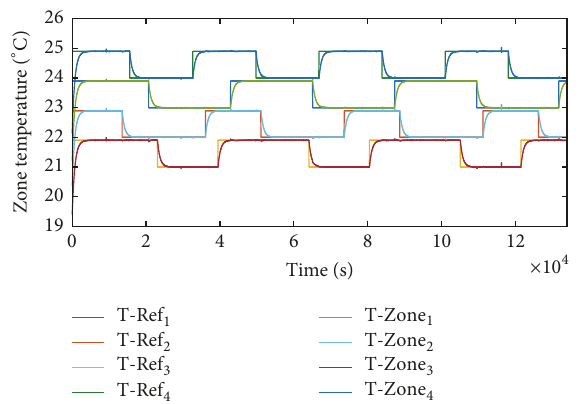
Figure 18: The outputs response of the zones temperature T-Zones with steps references T-Refs.